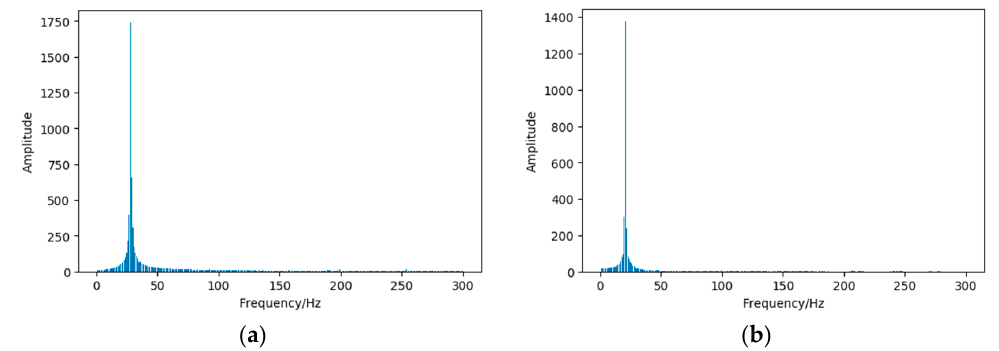
Figure 1. The output voltage of the marine current turbine (MCT) under different conditions: ( a ) The output voltage under a health condition; ( b ) The output voltage with uniform attachment.